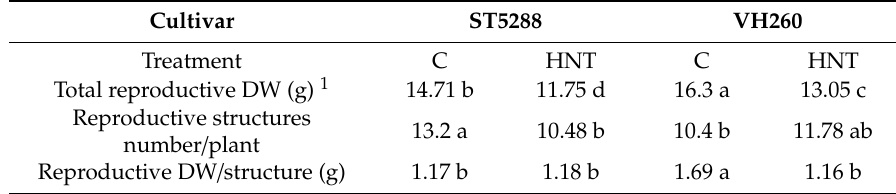
Table 1. E ff ect of high night temperatures on total reproductive dry weight, number of reproductive structures / plant, and individual reproductive unit dry weight at the end of the second week after treatment initiation. Columns connected with di ff erent letters are significantly di ff erent ( p = 0.05). (C: control temperatures 32 / 24 ◦ C, HNT: high night temperatures 32 / 30 ◦